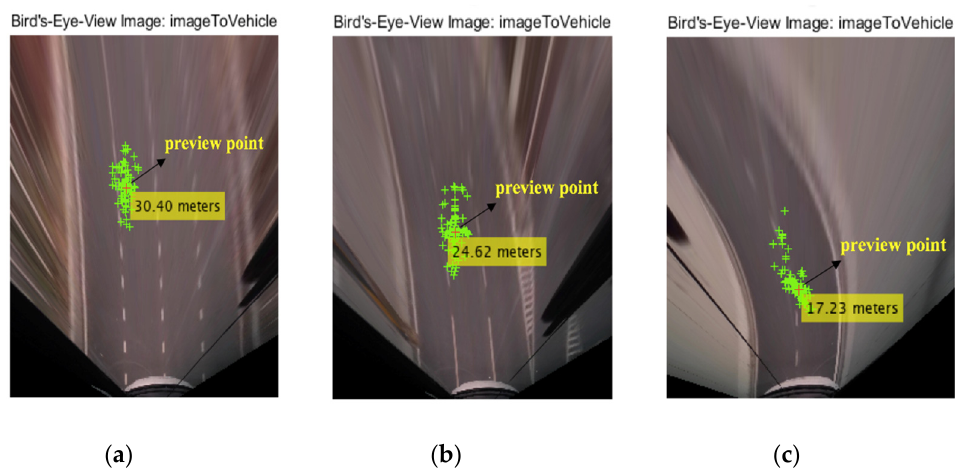
Figure 15. Bird’s-eye projection view of fixation points of subject 1 at a speed of 50 km/h on curves with radii of ( a ) 1500, ( b ) 800, and ( c ) 200 m.